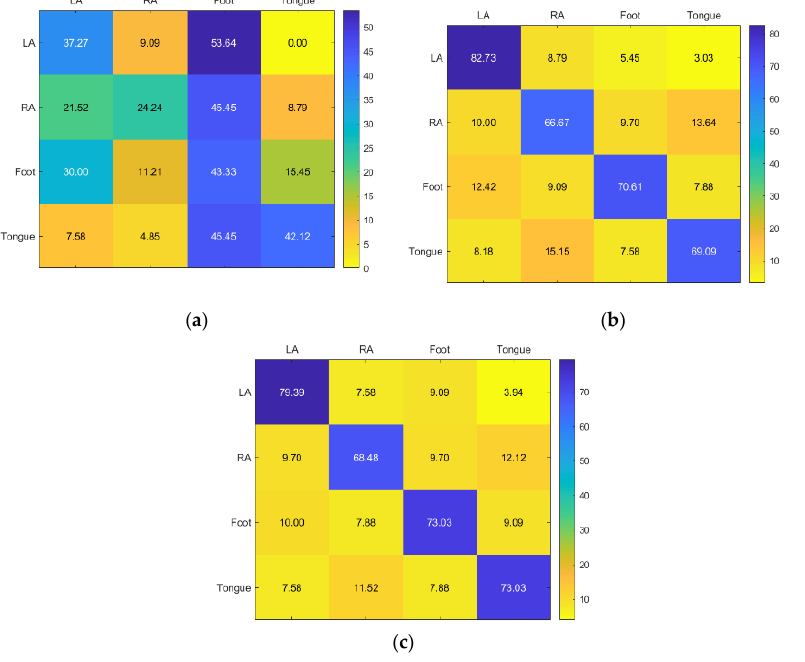
Figure 12. Confusion matrices for the ( a ) KNN, ( b ) SVM, and ( c ) RF classifiers to demonstrate the MI-BCI performance from the sixth subject’s four classes (left hand, right hand, feet, and tongue). Although tongue received acceptable accuracy from all three classifiers, LA, RA, and foot received poor accuracy from all three, with SVM receiving the best accuracy. The most accurate technology overall is still RF (Figure 13).